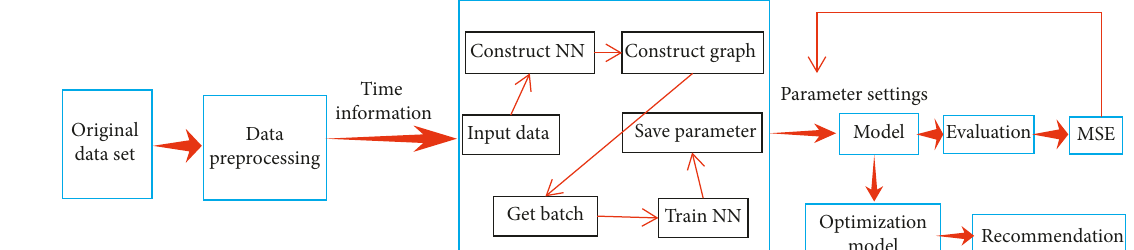
Figure 3: Flow chart of time-aware CNN-based personalized recommendation algorithm.